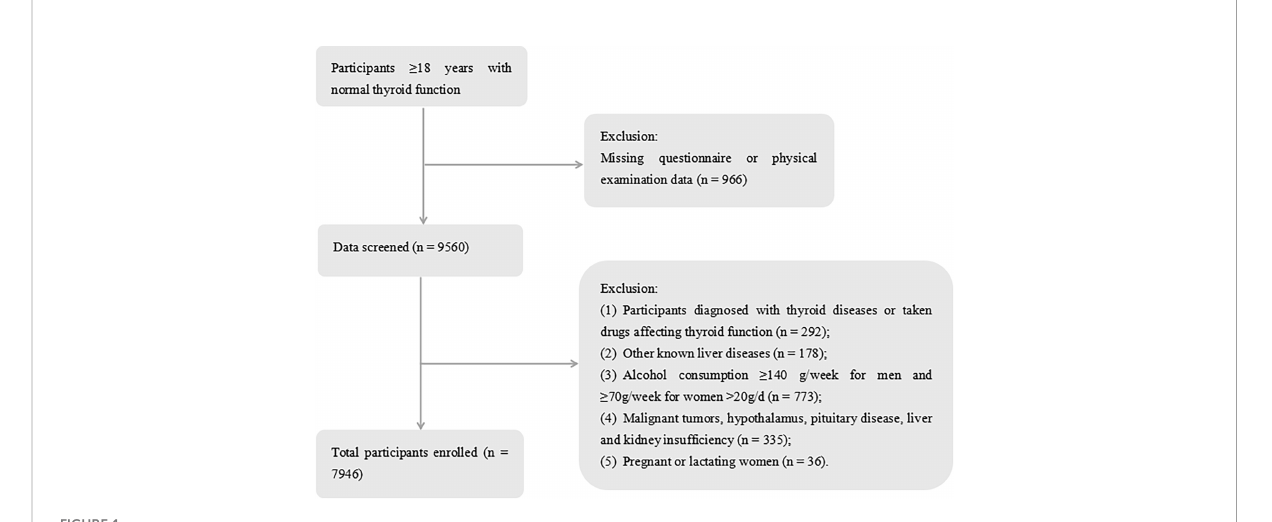
FIGURE 1 Flowchart of the inclusion and exclusion of